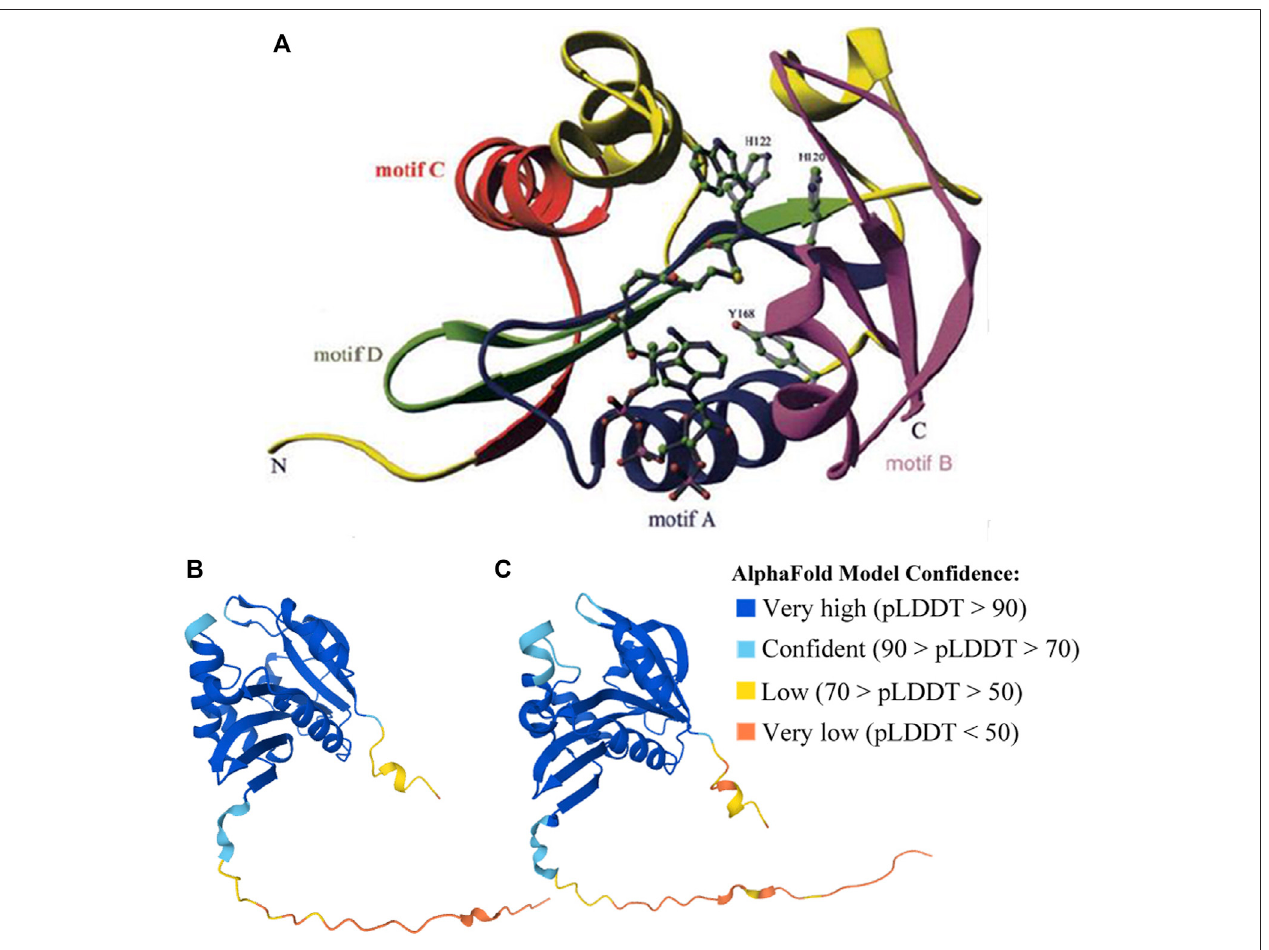
FIGURE 4 | Structures of human (validated) and zebra fi sh (predicted by AlphaFold) AANATs. (A) X-ray structure of human AANAT bound to bisubstrate analog, highlighting the four GNAT family motifs (marked as motifs A – D), and catalytic histidine (H120 and H122) residues. It was adopted from Scheibner et al. (2002). (B) Zebra fi sh AANAT1 (UniProt accession Q6V7J8). (C) Zebra fi sh AANAT2 (UniProt accession